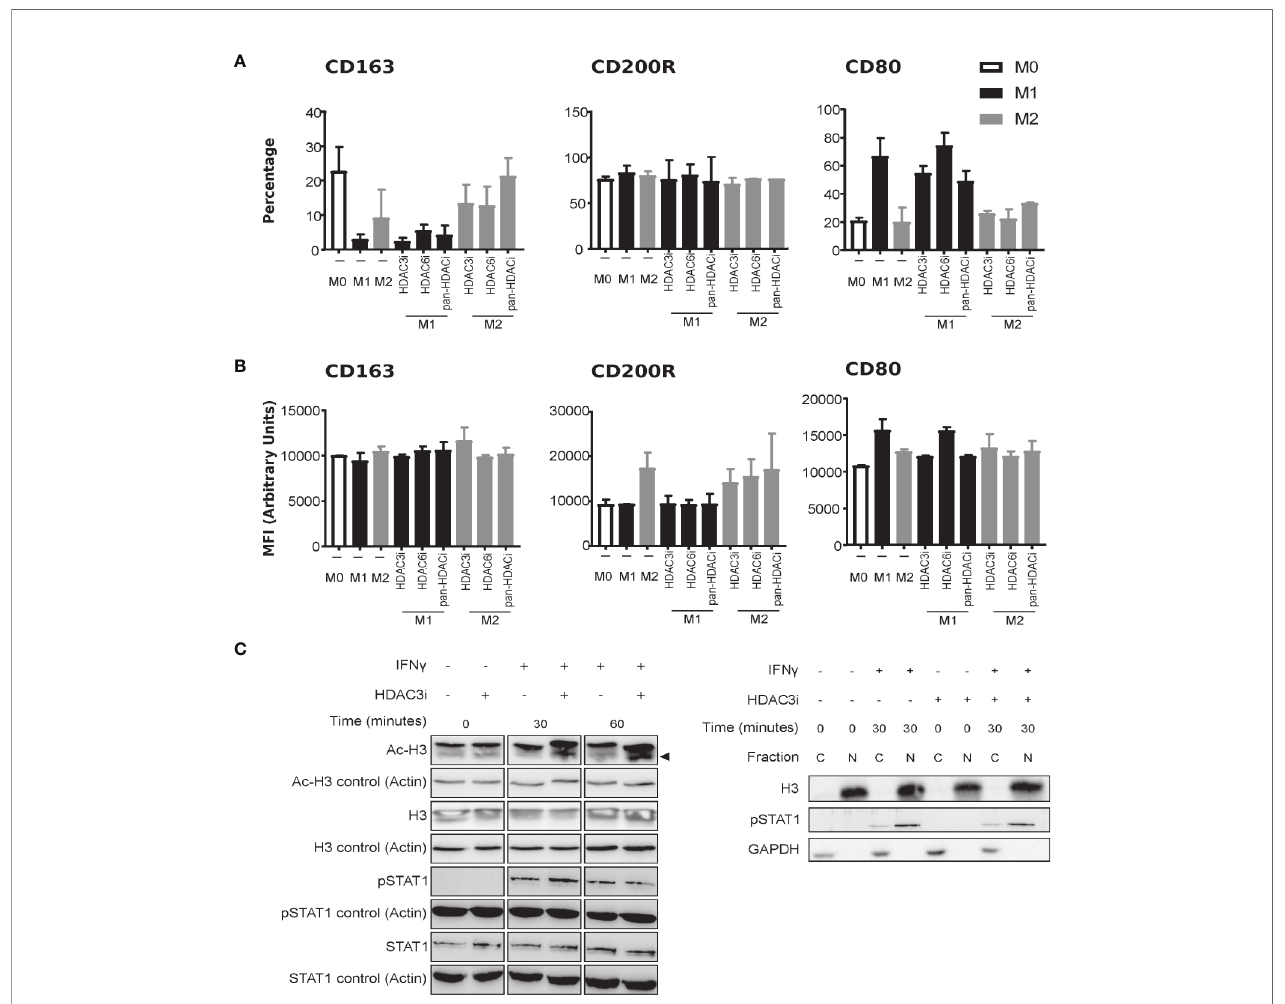
FIGURE 1 | The effect of HDACi on macrophage polarization and IFN g -induced STAT1 phosphorylation. Primary human CD14 + monocytes were treated with DMSO or 500 nM HDACi for 30 min prior to M0, M1 or M2 macrophages polarization, using media only, 50 ng/mL IFN g or 40 ng/mL IL-4, respectively. Protein expression of macrophage markers CD163, CD200R and CD80 was assessed by FACS. (A) Data presented as percentage of CD163 + , CD200R + and CD80 + cells from total cells or (B) by mean fl uorescence intensity (MFI) of CD163, CD200R and CD80 proteins (n=3). (C) Primary human CD14 + monocytes were polarized to M1 macrophages with 50 ng/mL IFN g after which they were left untreated or treated with 500 nM HDAC3i for 0, 30 or 60 min, followed by a subsequent treatment with 50 ng/mL IFN g for 24h. Total protein was assessed by Western blot for acetylated Histone H3 ( “ Ac-H3 ” ) and non-acetylated Histone H3 ( “ H3 ” ), phosphorylated STAT1 ( “ P-STAT1 ” ) and non-phosphorylated STAT1 ( “ STAT1 ” ) (left). Actin- a ( “ Actin ” ) was used as loading control. Protein levels were assessed for phosphorylated STAT1, and Histone H3 in the cytoplasmic ( “ C ” ) and nuclear ( “ N ” ) fractions (right). GAPDH was used as loading